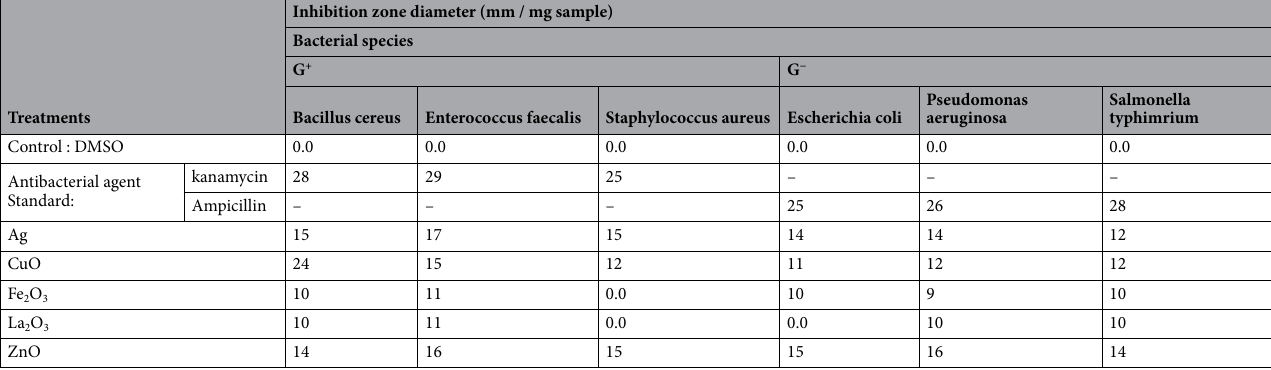
Table 4. Antibacterial activity of different biosynthesized nanoparticles from M. oleifera . G: Gram reaction; Solvent: DMSO .